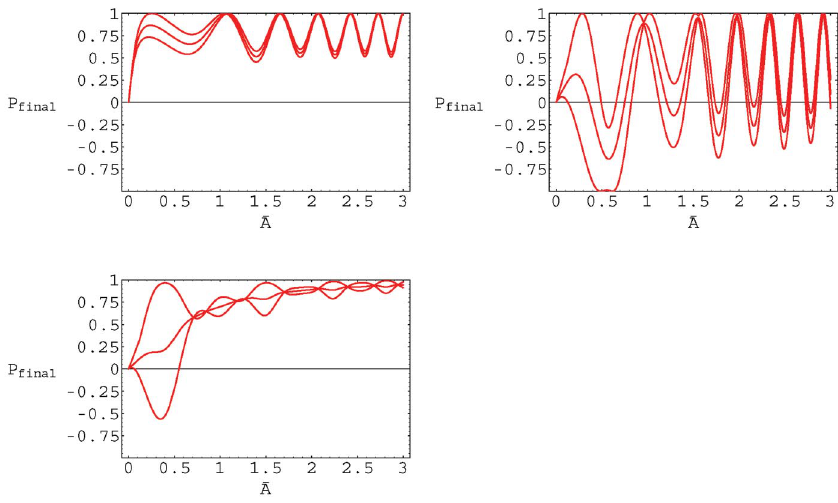
FIG. 9. (Color) Final polarization after twice crossing a resonance in a sloped-step pattern as function of (cid:5) A for three different values of (cid:5) (cid:3) .